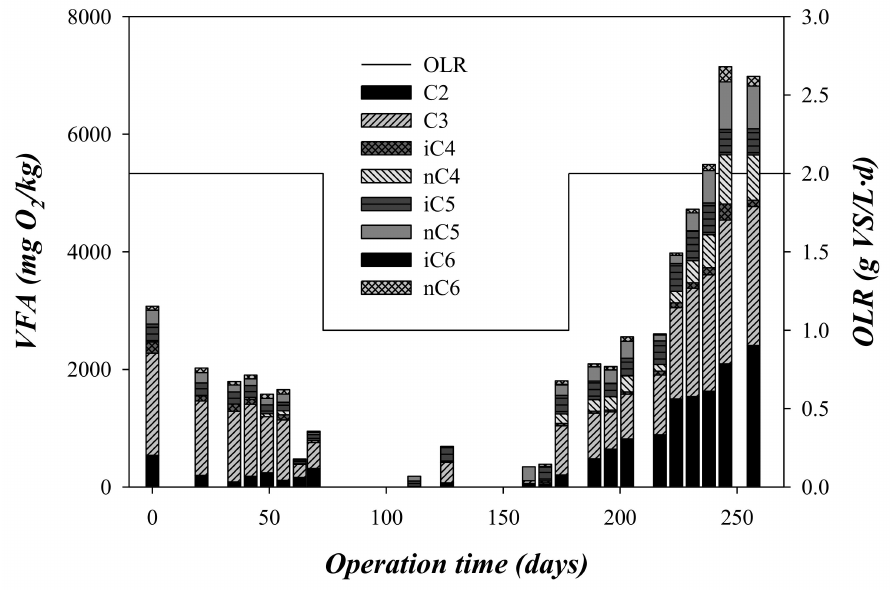
Figure 4. Variation of the VFA and the organic loading rate (OLR) with the operation